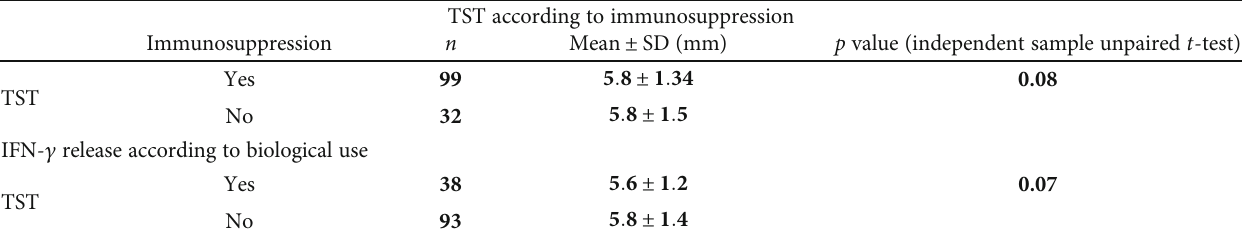
(a) Comparison of TST according to immunosuppression and biological use